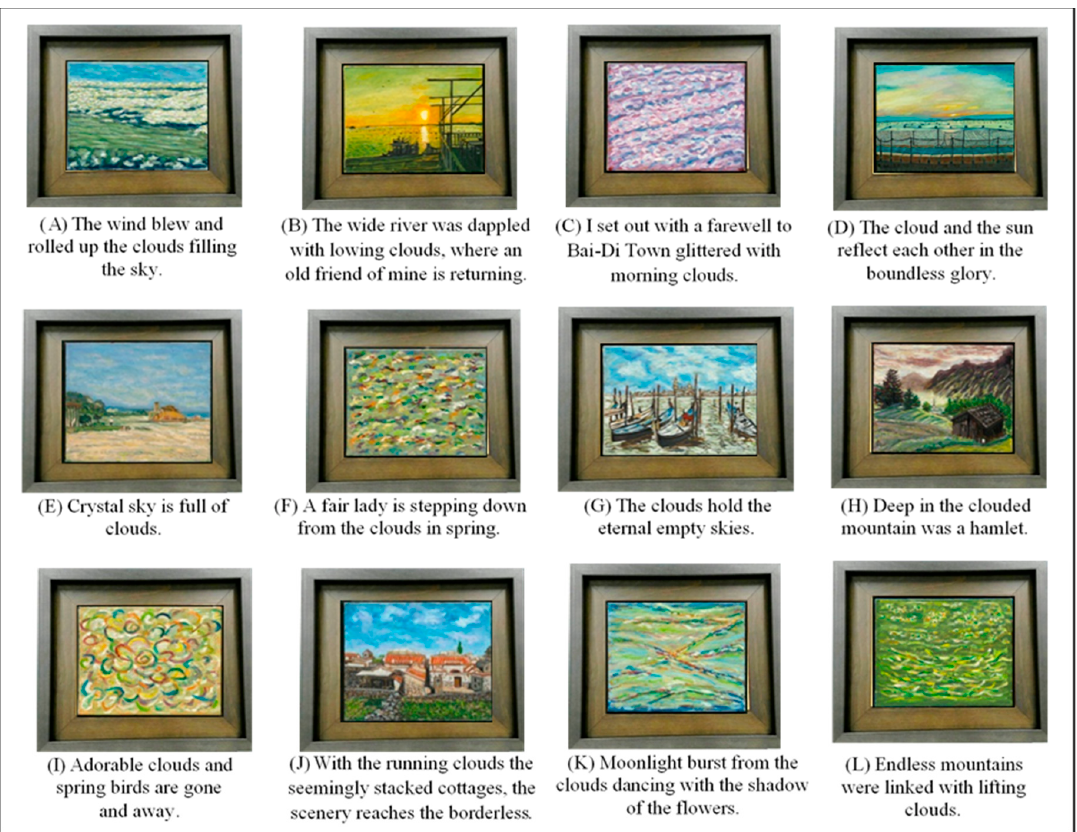
Figure 1. The twelve original paintings of this study.